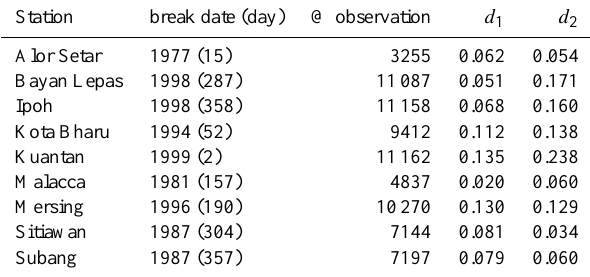
Table 4. CUSUM test with corresponding break date and esti- mates of the differencing parameters d 1 (before break) and d 2 (after